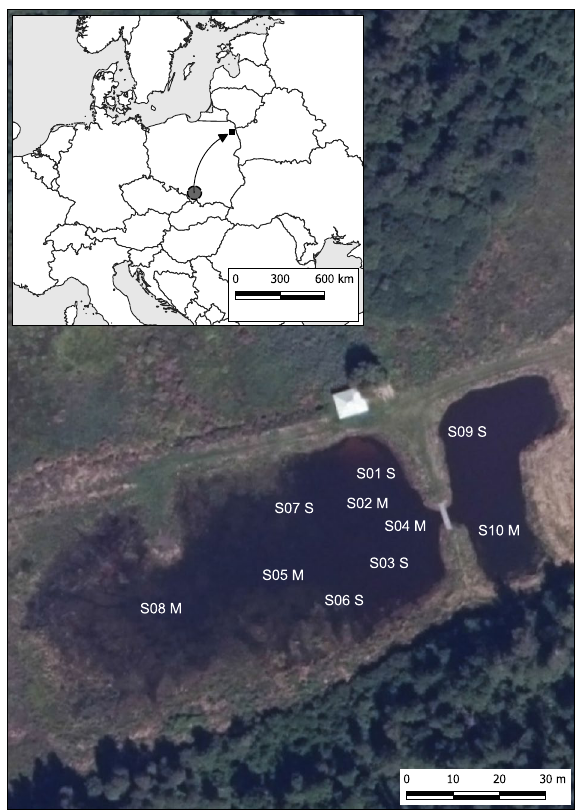
Figure 1. Map of the study area and location of the sampling sites. The grey circle indicates an approximate location of the source population for the introduction of S. woodiana. S01–S10, sampling sites; M, muddy bottom; S, sandy bottom. The map was generated using the QGIS 3.16.4-Hannover software (Free and Open Source Software (FOSS); Free Software Foundation, Inc., USA; www. qgis. org). Source for the orothophotomap: goeportal.gov.pl (Terms and conditions: https:// www. geopo rtal. gov. pl/ regul